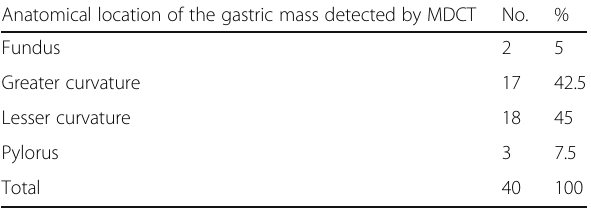
Table 2 Anatomical location of the gastric mass detected by MDCT